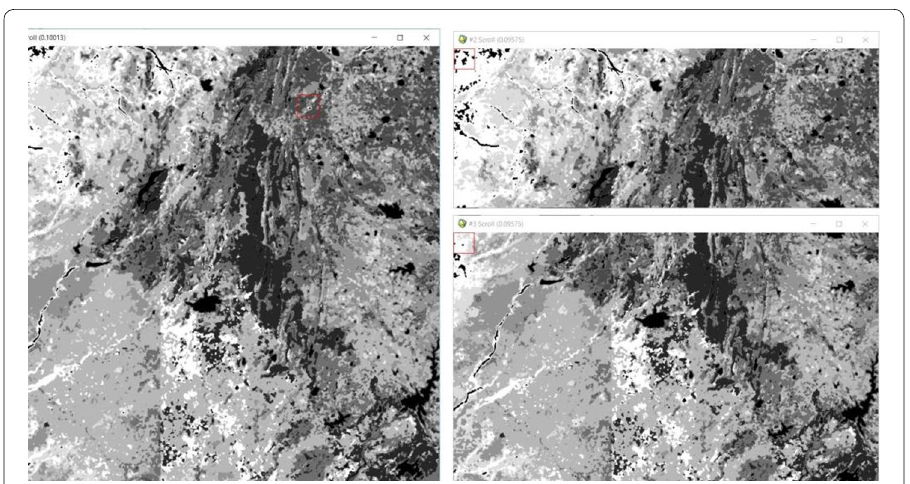
Fig. 14 Horizontal-split of the image in the